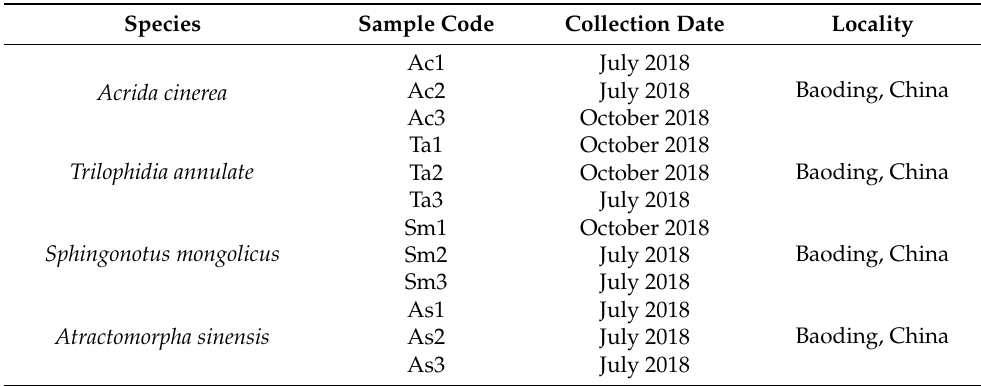
Table 1. Basic information of experimental